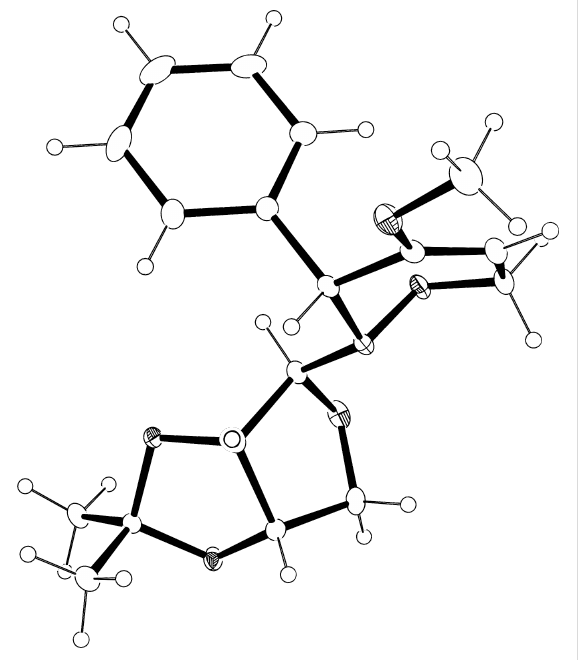
Figure 2: Single-crystal X-ray analysis of (3 R )- 3a (ellipsoids are drawn at a 50% probability